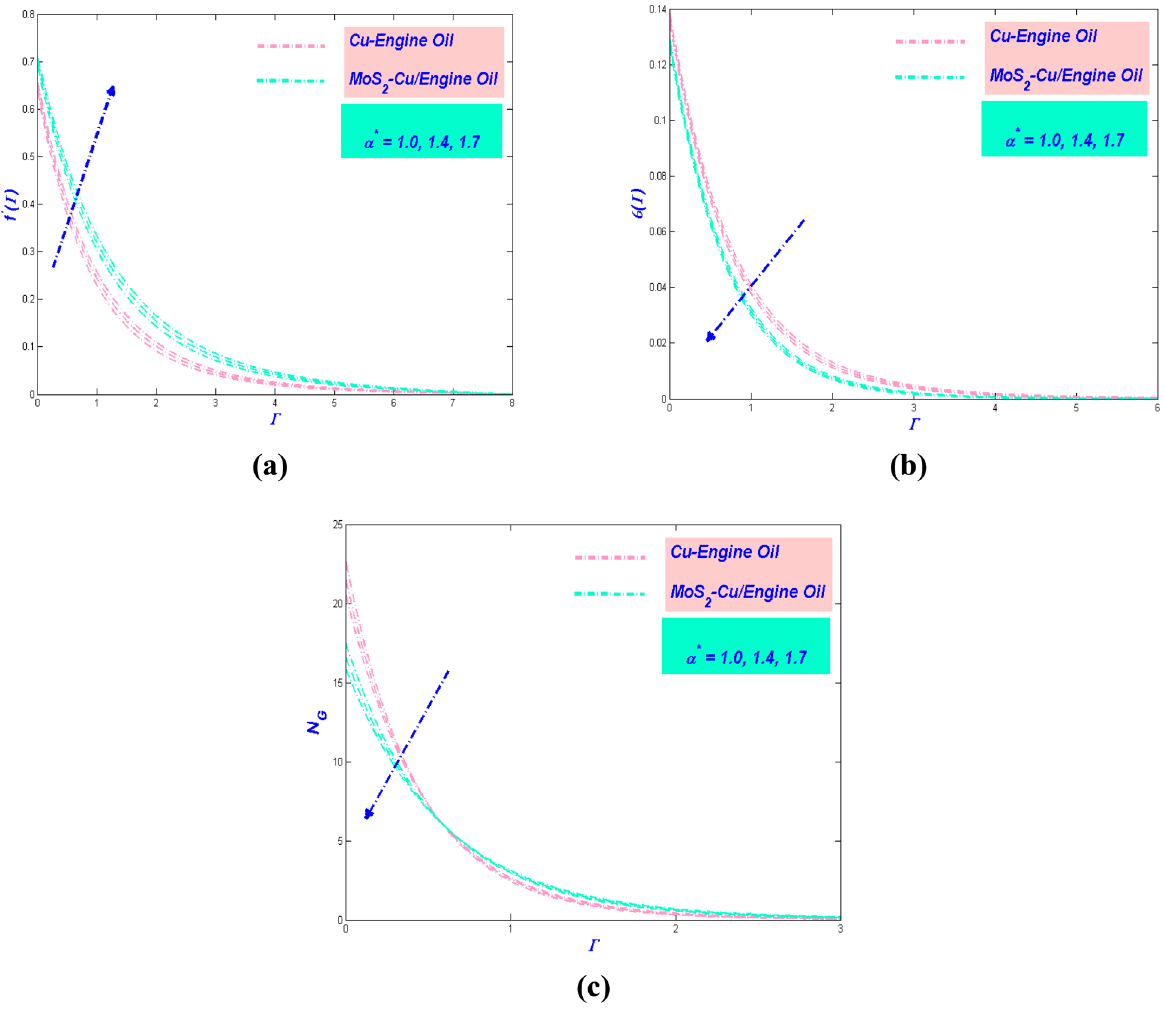
Figure 5. ( a ) Velocity, ( b ) temperature and ( c ) entropy variation versus α ∗